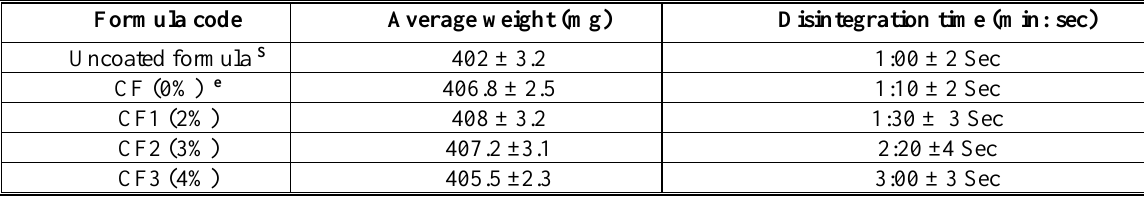
Table 7. Weight gain and disintegration time of the coated formula.